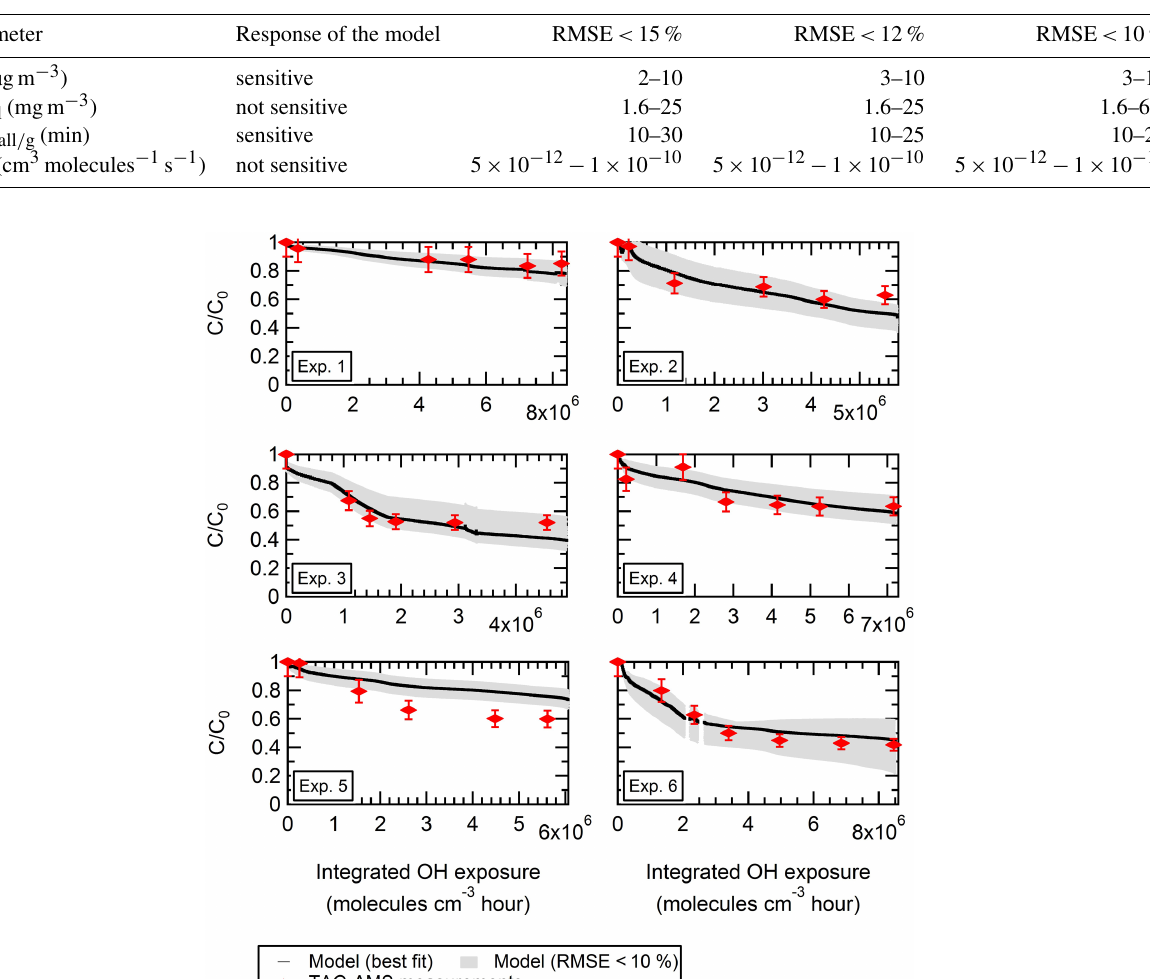
Figure 6. For each replicate, observed and modeled evolution during aging of the particle-phase concentration of levoglucosan pWLC (and normalized to the initial concentration) is shown. The colored markers are the TAG-AMS measurements. The solid black line represents = 9µgm − 3 , m = 1600µgm − 3 , 1 /k = 15min, and k = 5 × 10 − 12 cm 3 molecules − 1 s − 1 ). RMSE the best fit (with α = 0.1, C ∗ wall wall / w OH i is 7.63%, and mean bias is 0.008. The grey area shows all the individual combinations with a RMSE < 10% (see iteration 2 in Table